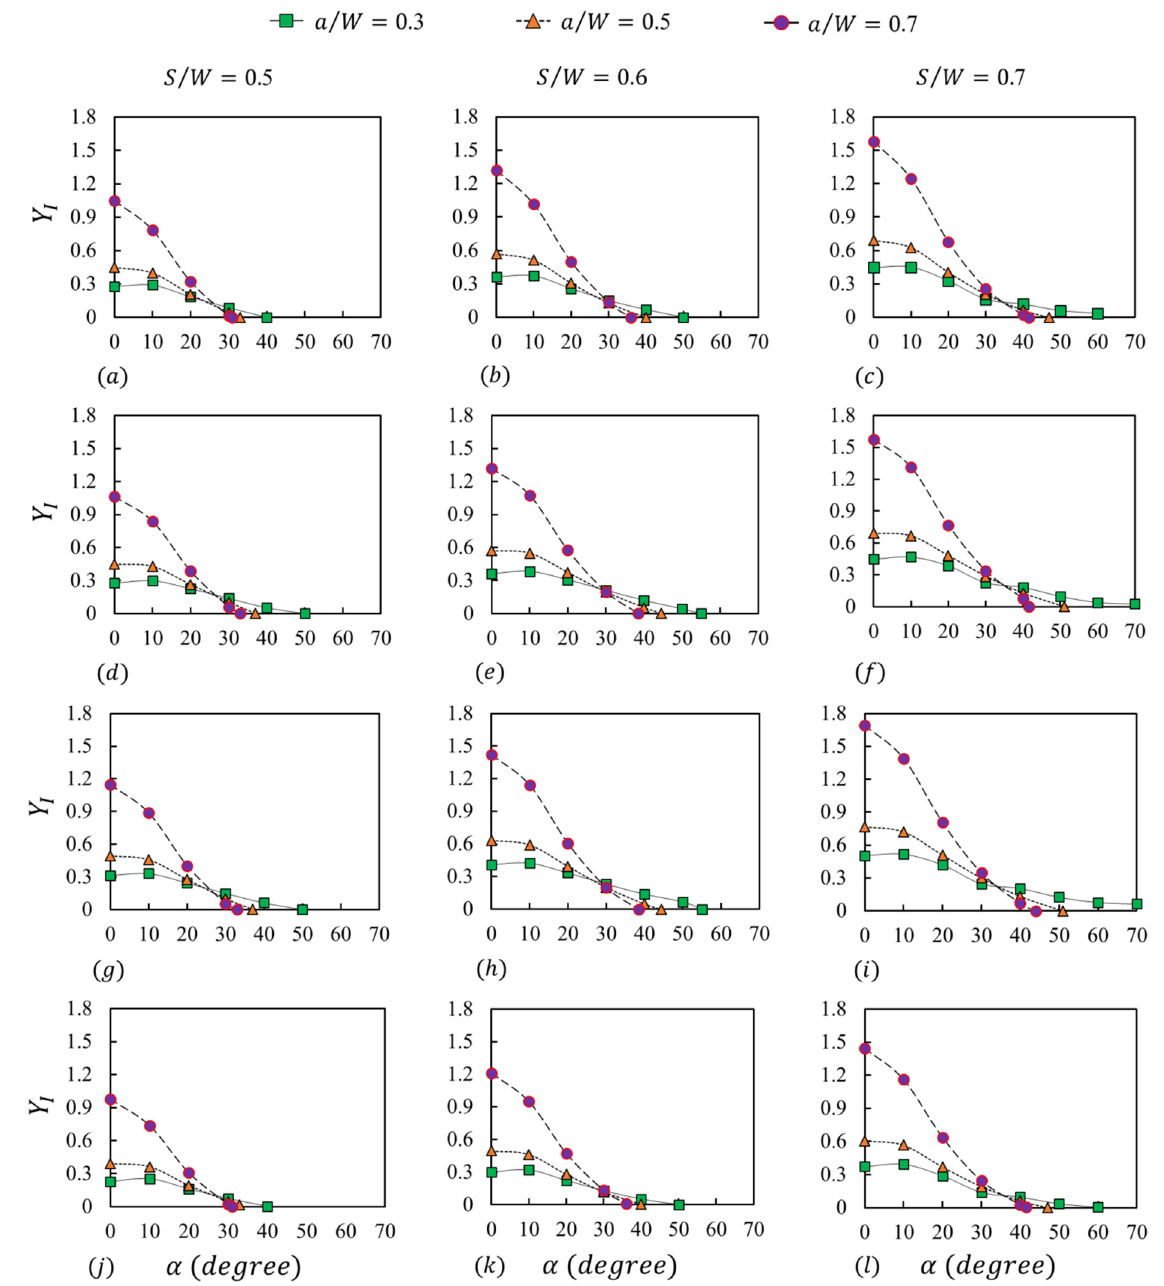
Figure 4. Variations of mode I geometry factor (Y I ) with crack inclination angle ( α ) for different BISBB specimens and different geometrical and loading conditions. ( a – c ) Al-Adhesive-Alumina, ( d – f ) Alumina-Adhesive-Al, ( g – i ) Al-Adhesive- Al, ( j – l )